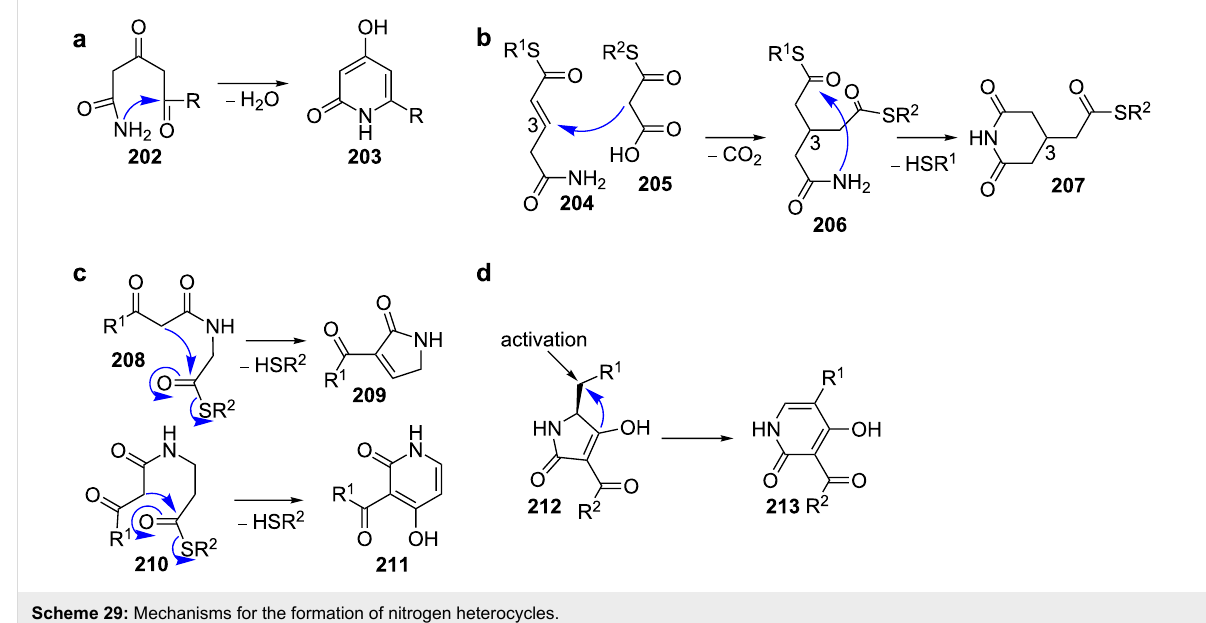
Scheme 29: Mechanisms for the formation of nitrogen